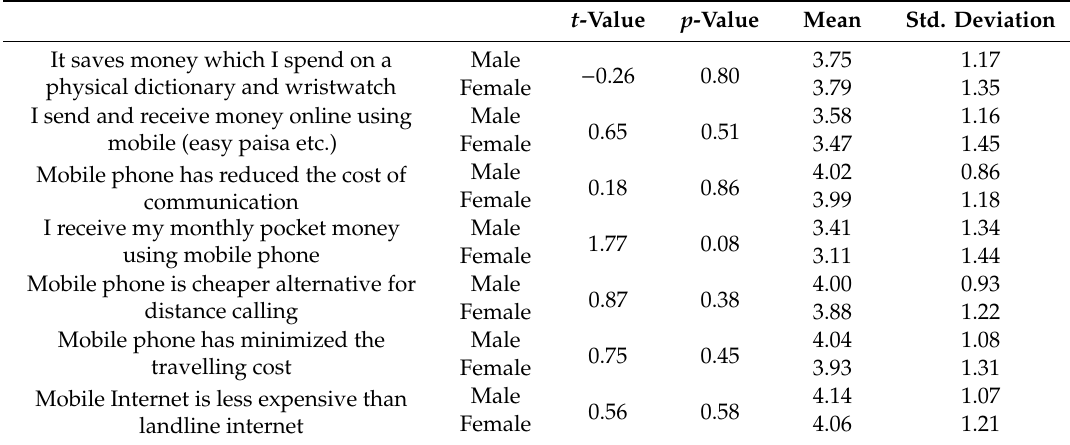
Table 7. T -test mobile phones’ impact on the economic status of youths.